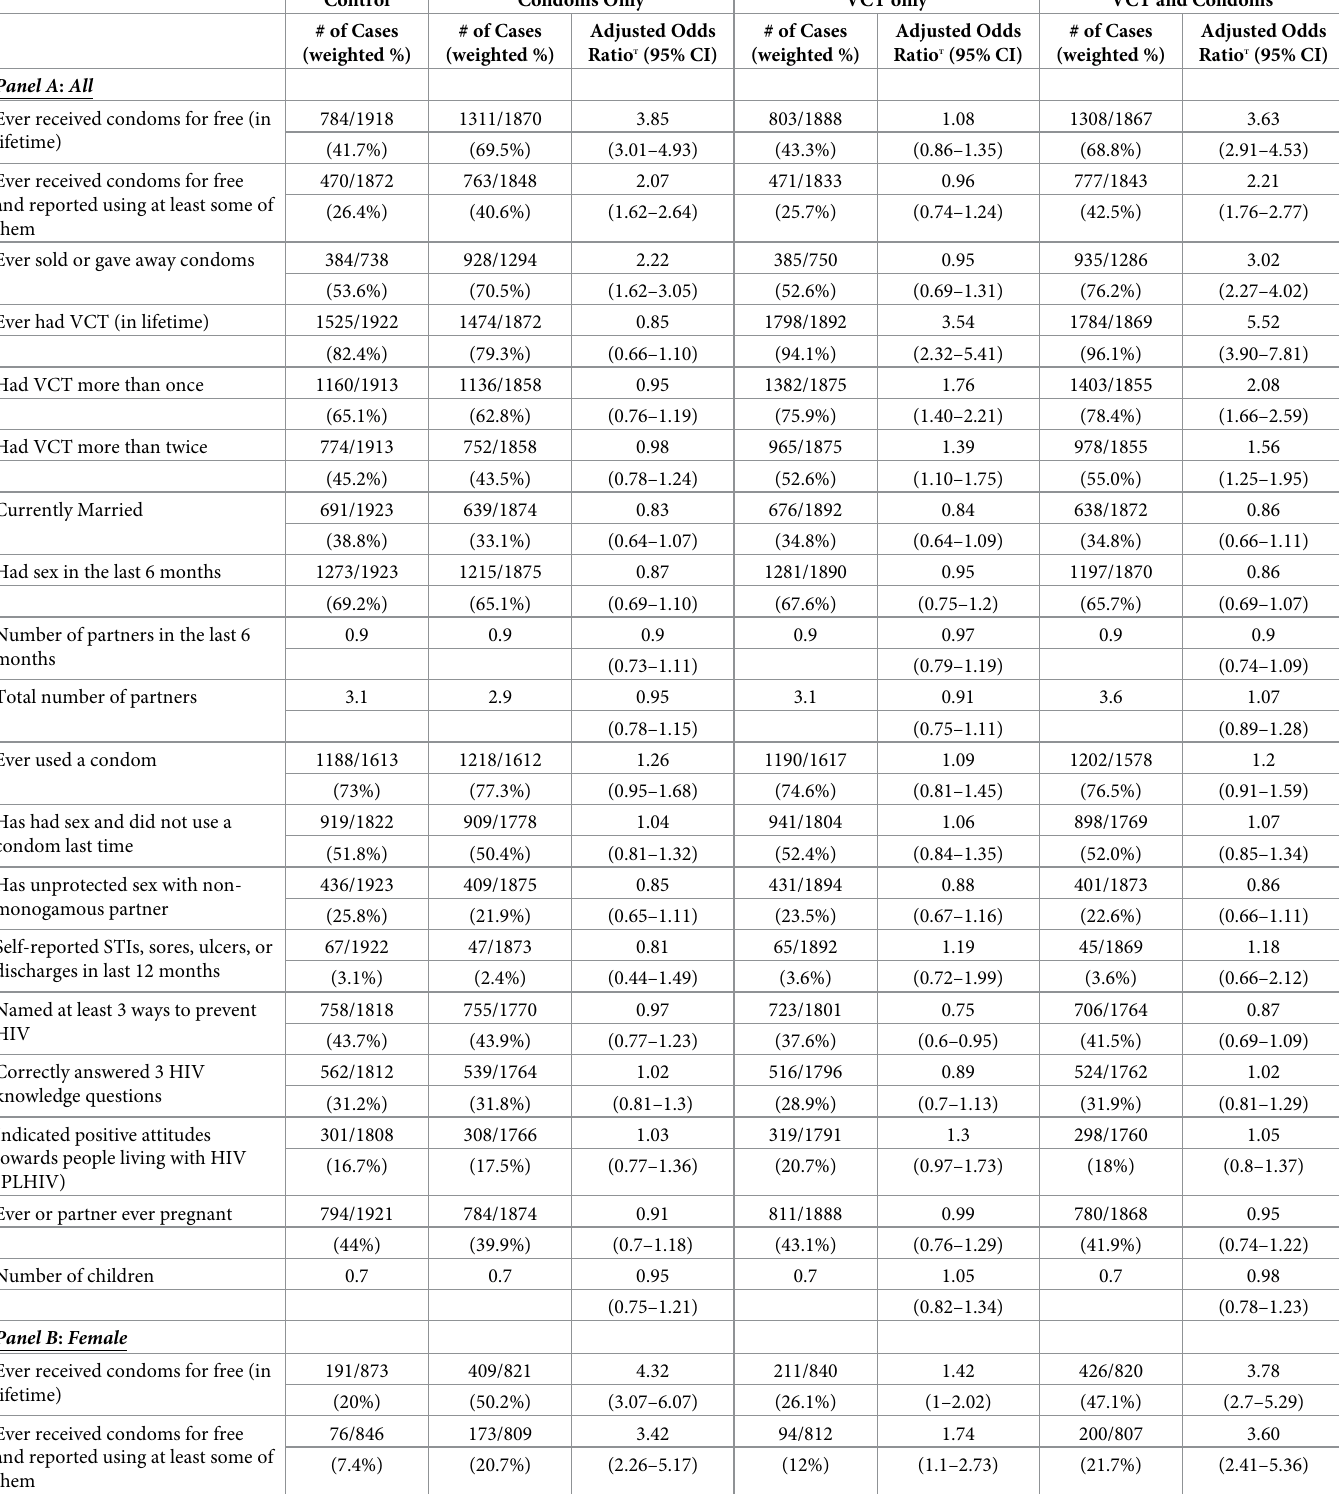
Table 3. Impact on secondary outcomes; intention to treat